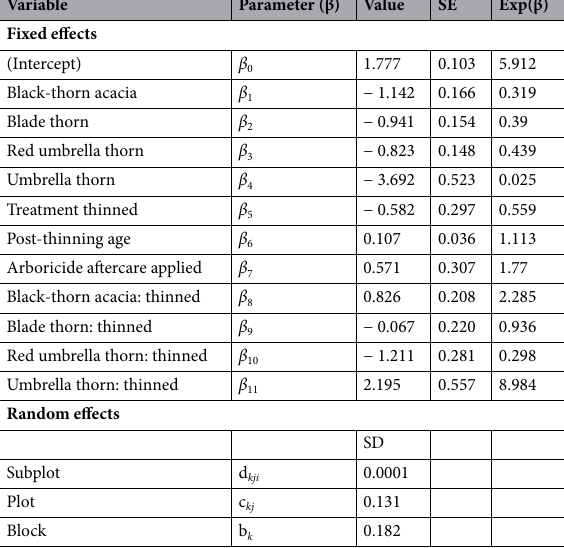
Table 2. Generalized linear mixed-effects model (GLMM) showing the effects of fixed factors (treatment, post-thinning age, and arboricide aftercare) on the abundance of encroaching trees/shrubs.